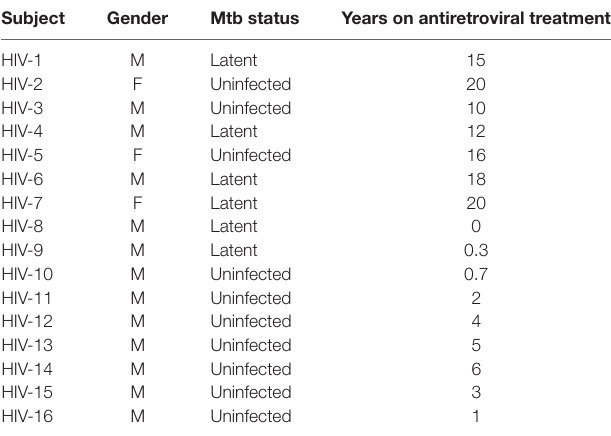
Table 2 | Demographics and Mycobacterium tuberculosis (Mtb) status of HIV- 1-infected